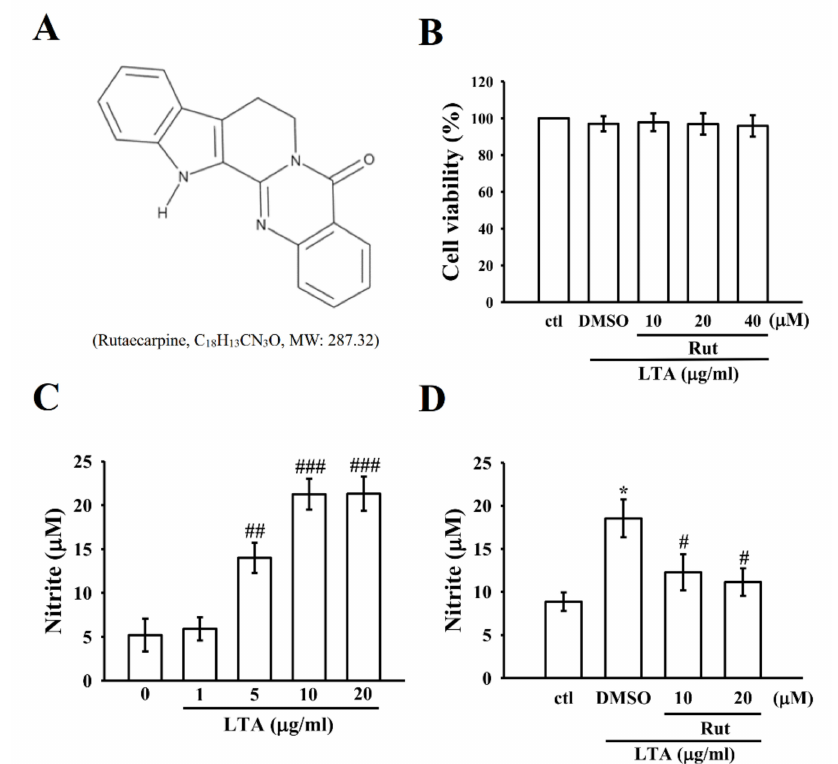
Figure 1. Effects of lipoteichoic acid (LTA) and rutaecarpine (Rut) on cell viability and nitric oxide (NO) production in RAW 264.7 cells. ( A ) Chemical structure of rutaecarpine. ( B ) Cells were treated with Rut (10–40 µ M) for 20 min and then treated with LTA (10 µ g/mL) for 24 h. Cell viability was assessed as described in the Methods section. Cells were treated with ( C ) various concentrations of LTA (1–20 µ g/mL) for 24 h ( D ) 0.1% dimethyl sulfoxide (DMSO) or Rut (10 and 20 µ M) for 20 min and then treated with LTA (10 µ g/mL) for 24 h to measure NO (nitrite) by using a Griess reagent. Data are presented as the means ± SEM ( n = 4). * p < 0.05, compared with the control group; # p < 0.05, ## p < 0.01, and ### p < 0.001, compared with the LTA